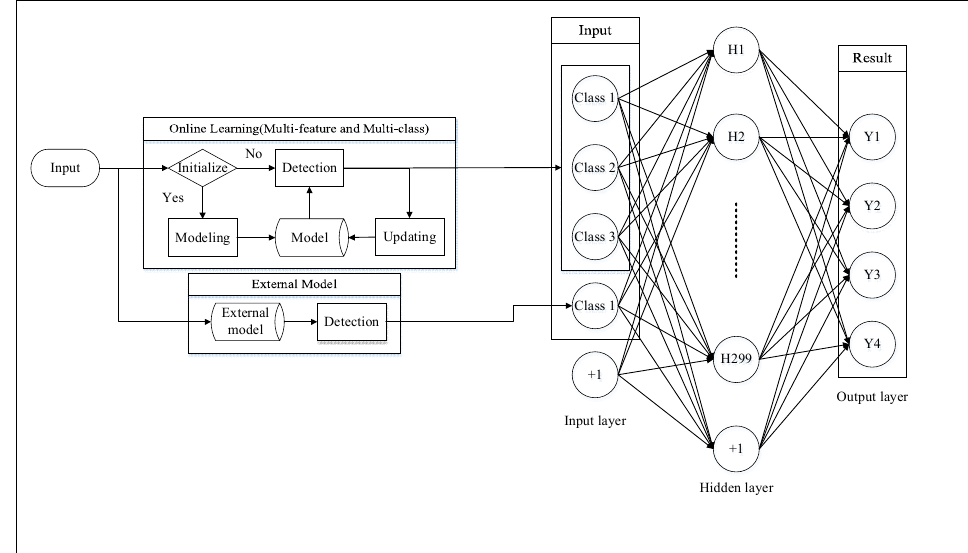
Figure 19. Illustration of the neural network.